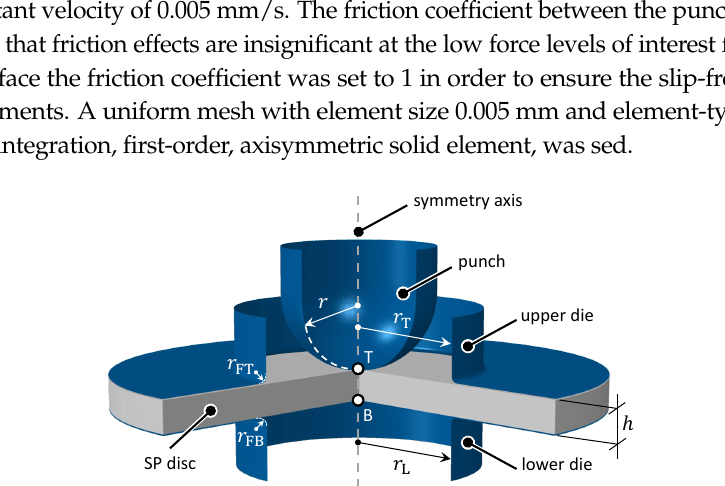
Figure 1. A schematic depiction of the Small Punch (SP) test for which an axisymmetric finite element model is developed. Here, the punch and the dies are modelled as rigid surfaces. The SP disc is modelled as a deformable body which is uniformly discretised using CAX4R elements with element size of 0.005 mm. At the central point at the top surface, denoted by T, displacement readings for an ideally stiff loading frame are realized whereas deflection readings are realized at the central point at the bottom surface, denoted by